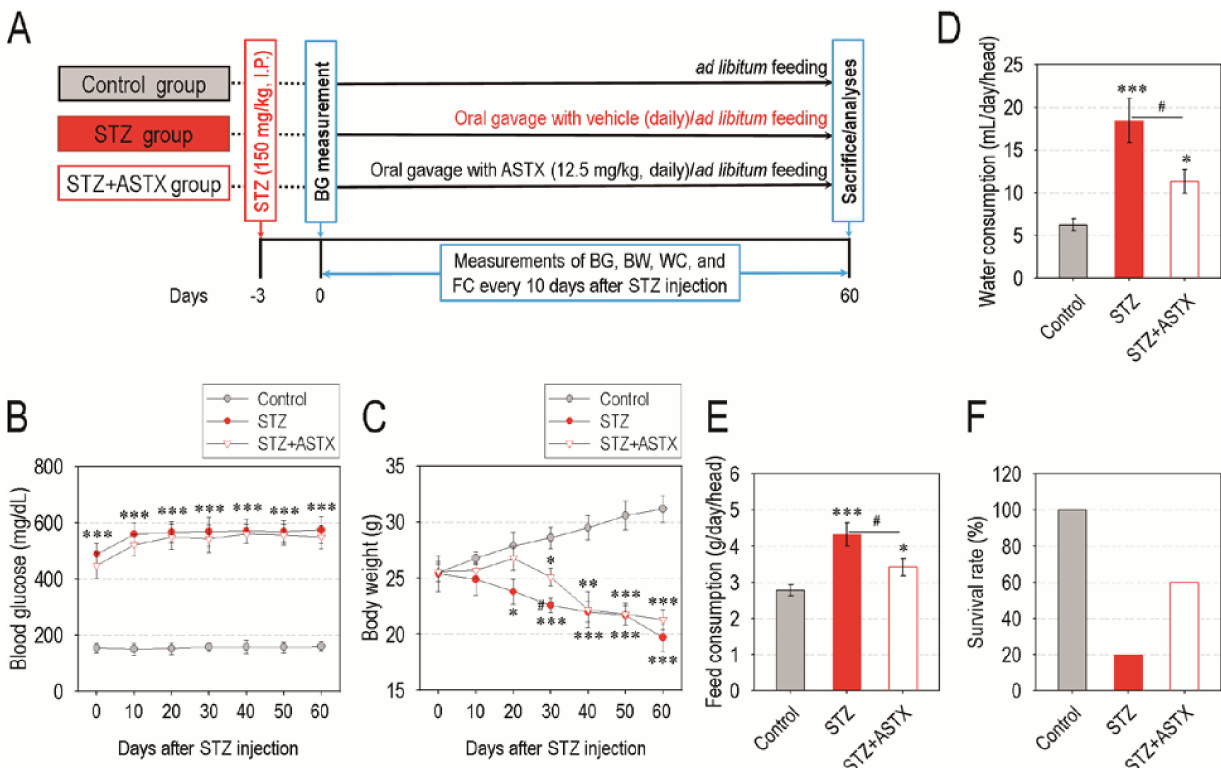
Figure 1. Oral gavage with astaxanthin (ASTX) does not ameliorate blood glucose level, but decreases excessive consump- tions of water and feed and lethality in STZ-induced diabetic mice. ( A ) A scheme illustrating the experimental designs. ( B ) Blood glucose level and ( C ) body weight in mice groups were measured at the indicated days after hyperglycemia induction ( n = 10). Amounts of ( D ) water and ( E ) feed consumption in mice groups were evaluated 30 days after hyper- glycemia induction ( n = 7). ( F ) Survival rate (%) of mice groups 12 h after the oral gavage for 60 days with ASTX ( n = 10). * p < 0.05, ** p < 0.01, and *** p < 0.001 vs. control group; # p < 0.05 vs. streptozotocin (STZ) group. BG, blood glucose; BW, body weight; WC, water consumption; FC, feed